Question: Which kind of chart has been used to present this data?
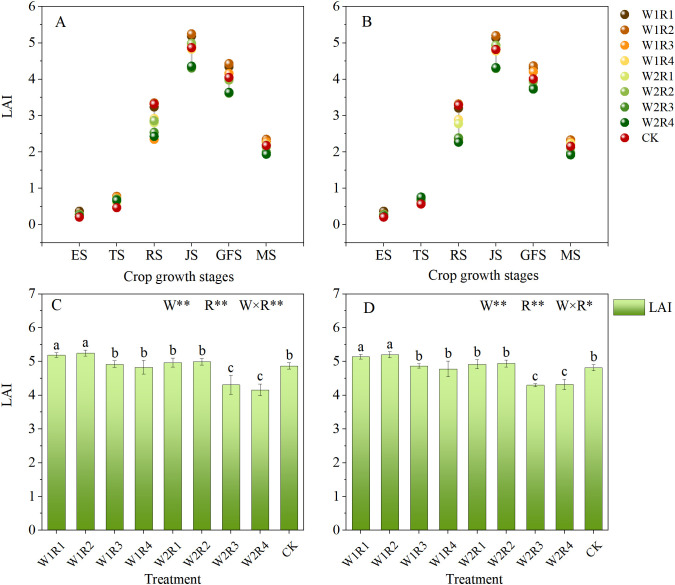
Answer: histogram